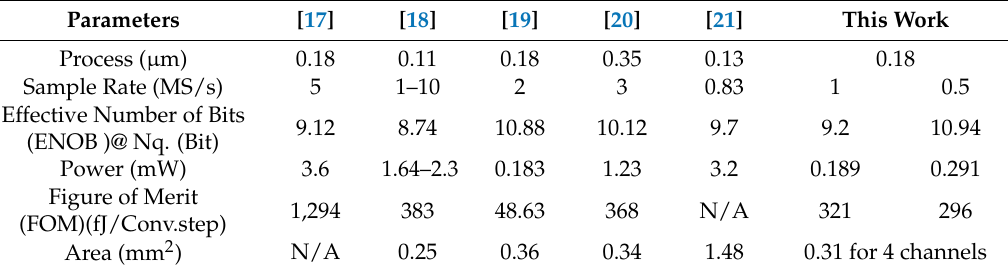
Table 1. Performance and comparison